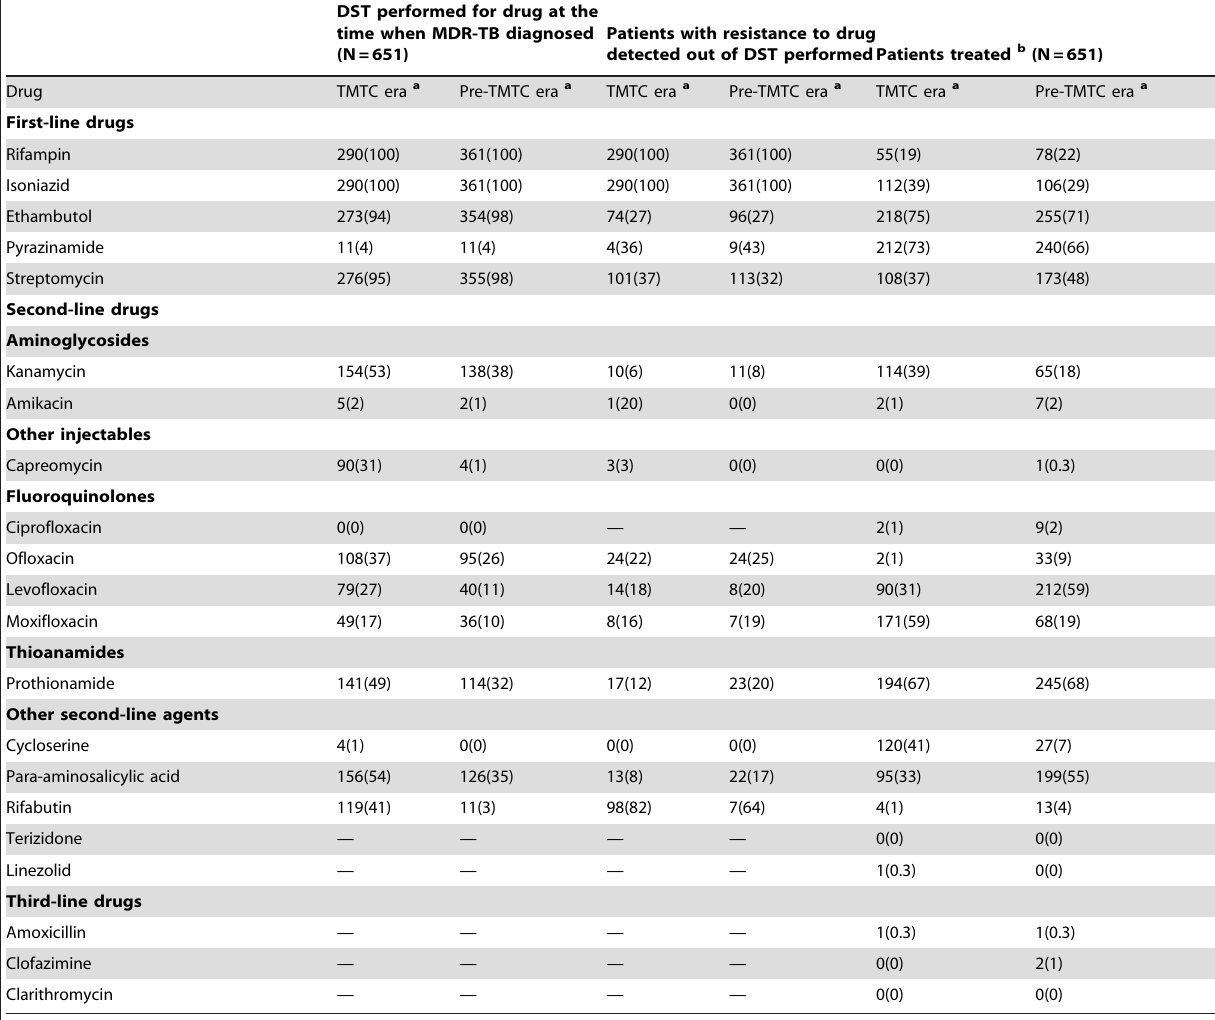
Table 2. Available DST results, drug resistance pattern and regimens prescribed in the beginning of the treatment of MDR-TB.